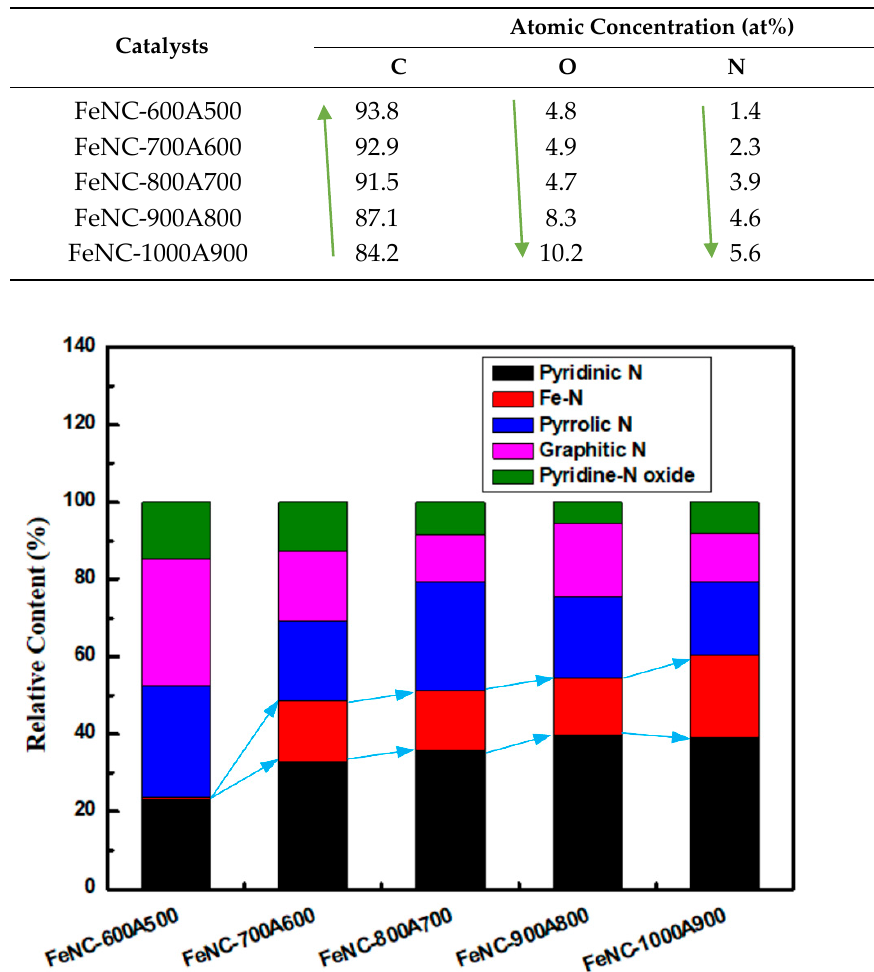
Figure 3. Relative compositions of each type of nitrogen-containing compound found in various FeNC matrices. Table 2. Compositions of various –Ns of FeNCs determined by XPS